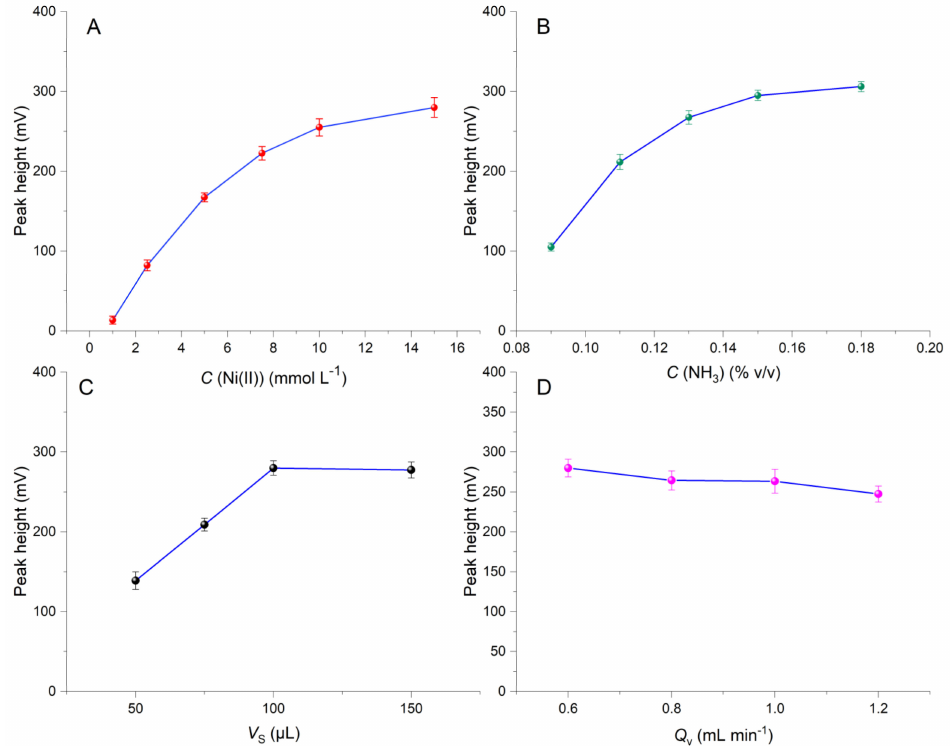
Figure 1. Effect of the ( A ) Ni(II) concentration ( C (Ni(II)), ( B ) NH 3 concentration ( C (NH 3 )), ( C ) sample volume ( V s ) and ( D ) flow rate ( Q v ) on the sensitivity of the proposed ZF